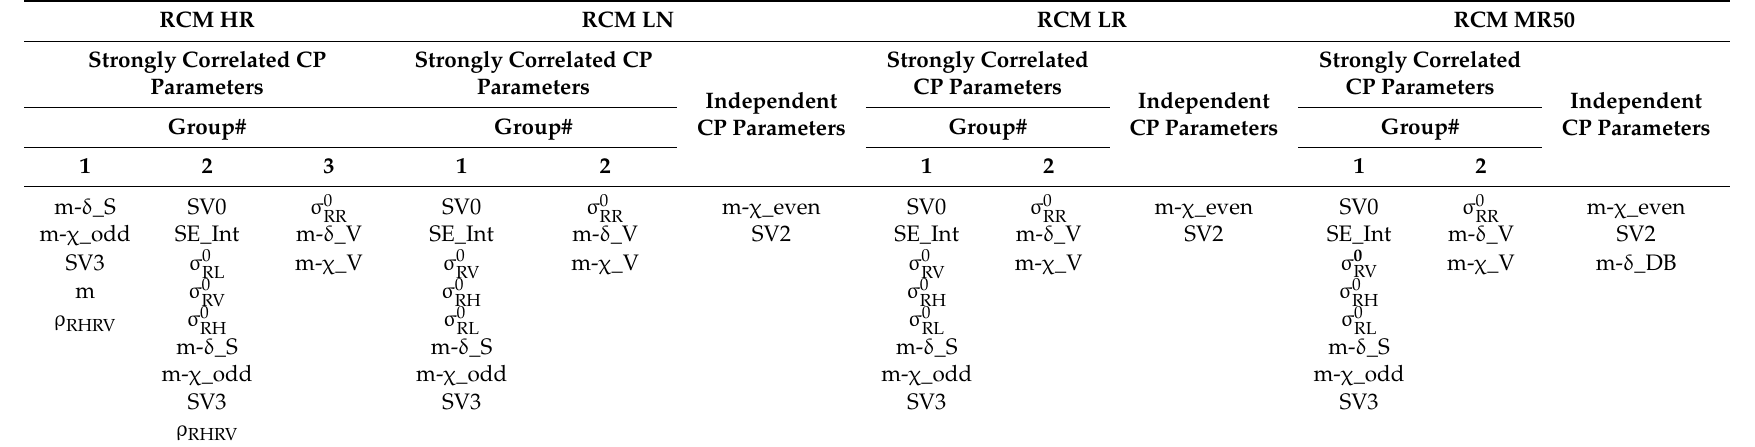
Table 4. Grouping of strongly correlated and independent CP parameters. HR = High Resolution, LN = Low Noise, LR = Low Resolution, and MR50 = Medium Resolution 50 m. RCM HR RCM LN RCM LR RCM MR50 Strongly Correlated CP Strongly Correlated CP Strongly Correlated Strongly Correlated Parameters Parameters CP Parameters CP Parameters Independent Independent Independent CP Parameters CP Parameters CP ParametersGroup# Group# Group#